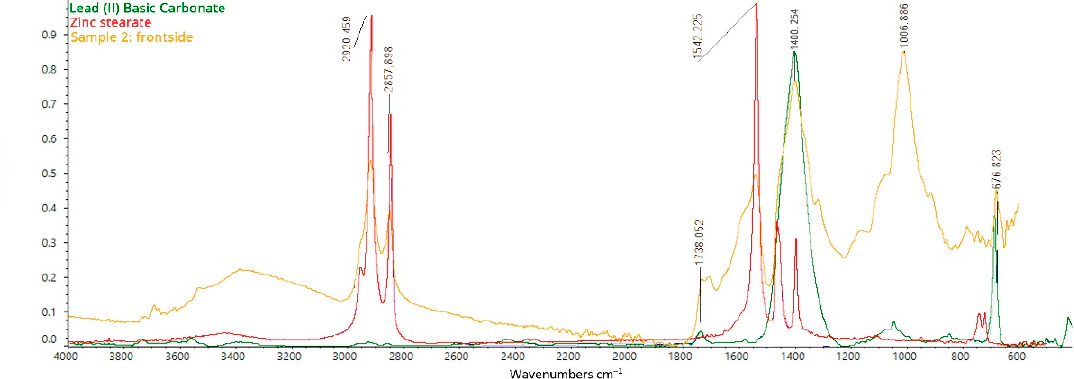
Figure 11. FT-IR ATR spectrum acquired on the front side of sample 2, consisting of the original canvas, the preparation layer, the primer, and the paint layers: analysis of the paint layer on the top. The peak at 1378 cm − 1 corresponds to the wagging vibration of –C–H 2 , that at 1100 cm − 1 to the asymmetrical stretching of –O–CH 2 –C, and that at 723 cm − 1 to the rocking of –(C–H 2 ) n – and the wagging of (C–H)=C–H, all confirming the presence of a